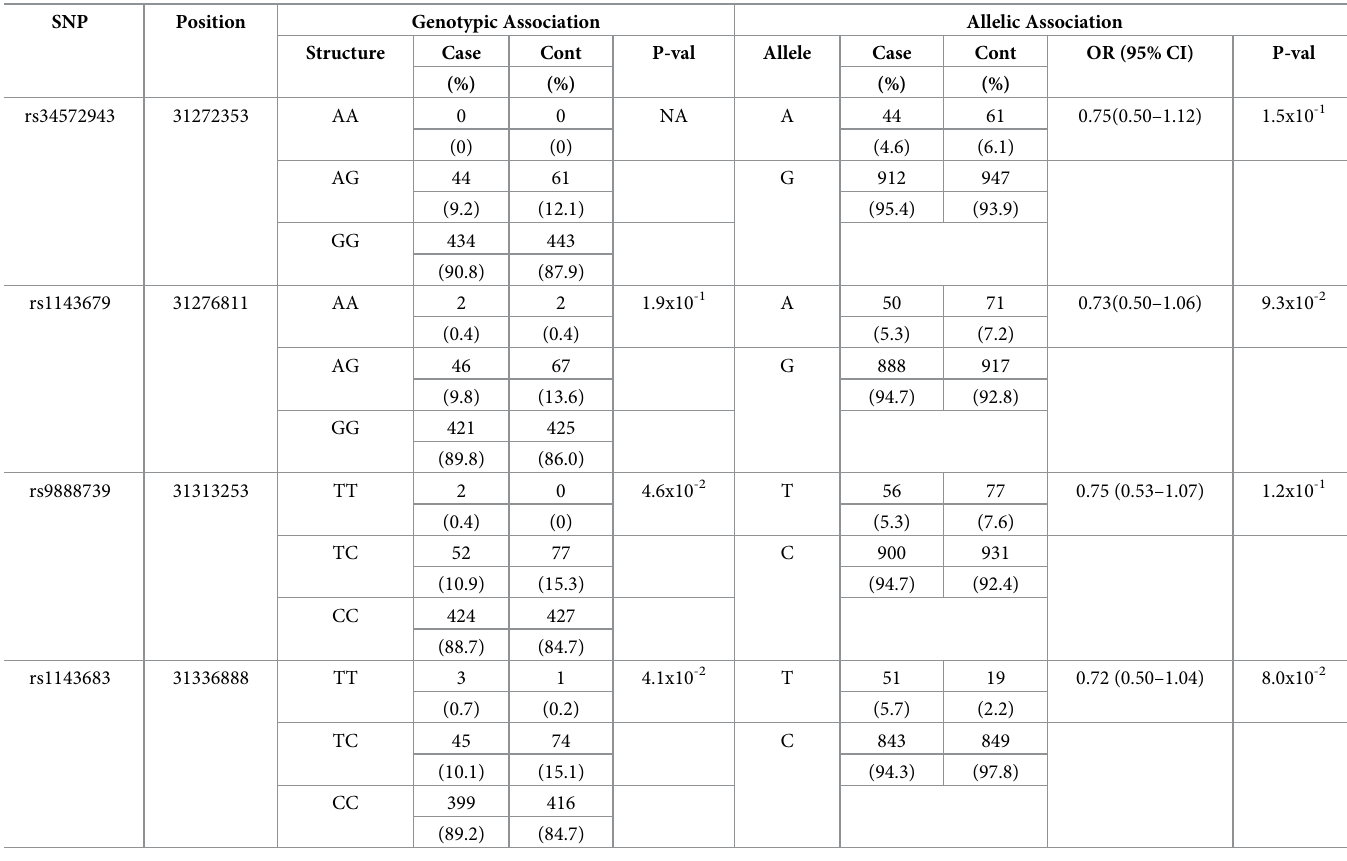
Table 3. Genotypic and allelic frequencies of the ITGAM polymorphisms and association analysis in patients with RA and controls from Central Me´xico. SNP Position